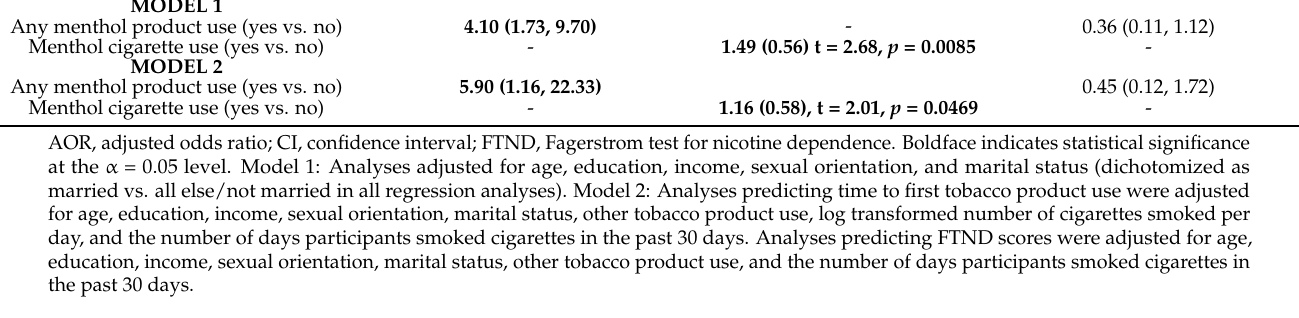
Table 3. Adjusted Odds of Nicotine Dependence and Ever Engaging in Cigarette Quit Attempts. Time to First Tobacco Product Use Predictor ( ≤ 5 min vs. >5 min) MODEL 1 Any menthol product use (yes vs. no)